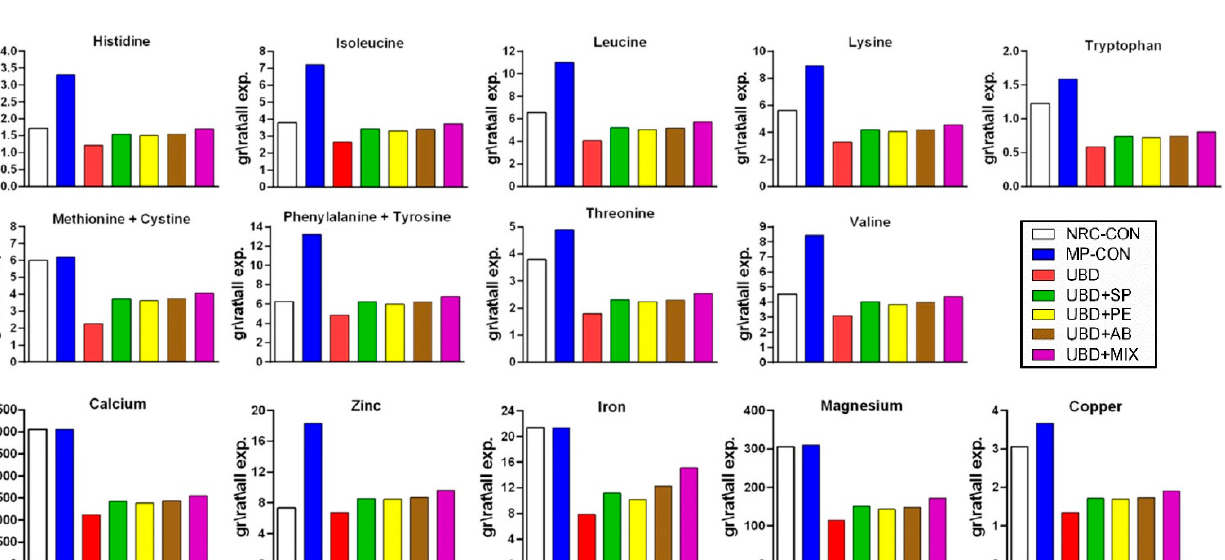
Figure 6. Fatty acid profiles. Lipids were analyzed by gas chromatography–mass spectroscopy. 3.4. Microbiome Analysis In order to assess the specific changes in the rats’ intestinal microbiota, 16SrRNA se- quencing was preformed from caecum samples of 9 weeks old rats. Alpha diversity was calculated using the Shannon index in order to evaluate the di- versity in each of the tested caecum samples. Significantly decreased was found in the UBD group compared with the CON group. Supplementation of PE, AB or Mix was able to significantly increase the alpha diversity; however only trends of improvement were found with SP supplementation (Figure 7A). Principal coordinate analysis (PCoA) was used with the aim to evaluate the ecologi- cal distance between samples and produce a graphical configuration in a low-dimension.